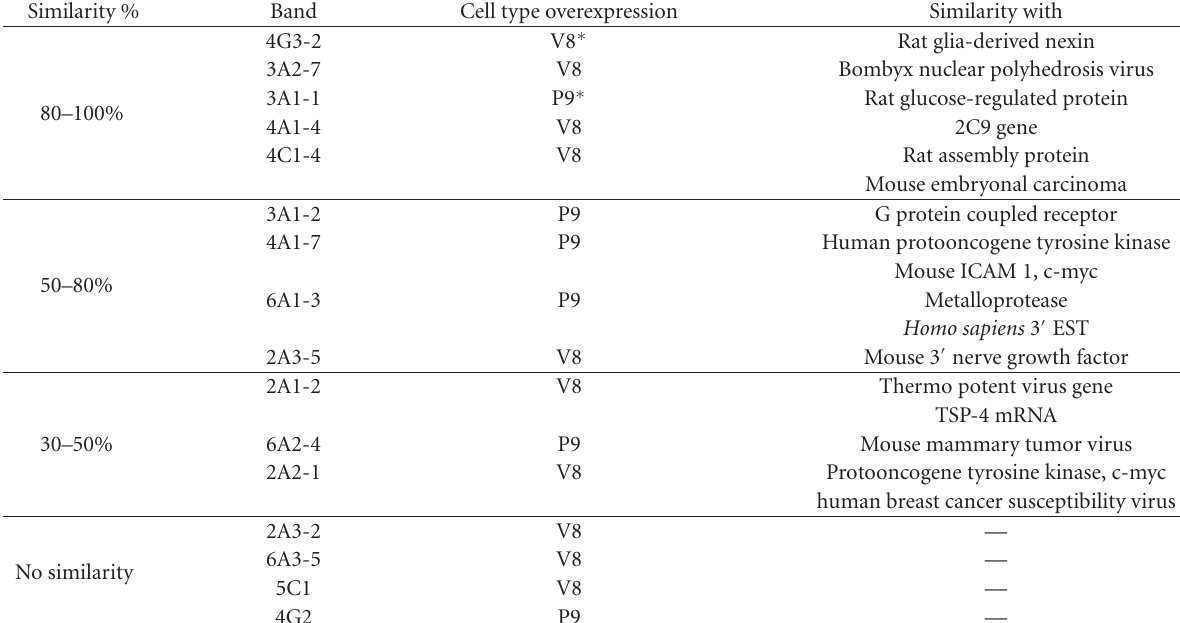
Table 1. Summary of similarities (%) with identified genes in databases. Results were classified in di ff erent categories (80–100%, 50–80%, 30–50%, or no similarity). The band 3A2–4 means that the 5 (cid:1) primer used was arbitrary primer 3 (AP3), and the 3 (cid:1) primer was dT 11 A. P9 ∗ and V8 ∗ indicate synthetic and proliferating cells,